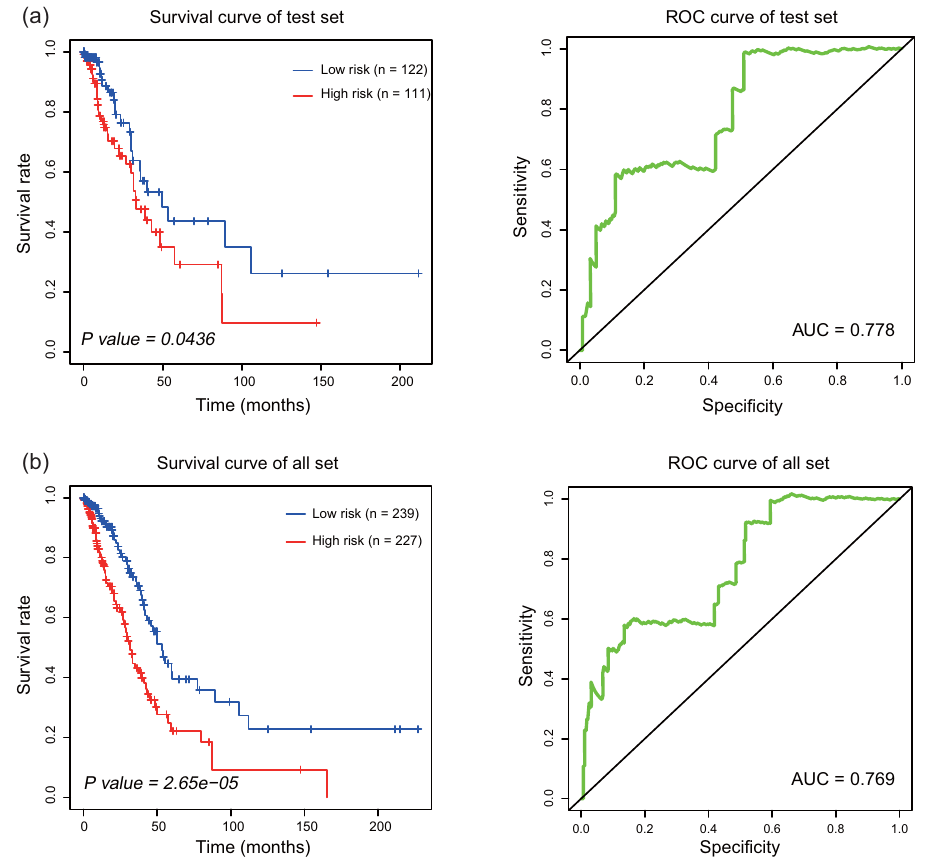
Figure 3: Prognostic value of four - lncRNA signature in the test set and entire set. ( a ) Kaplan – Meier curve and ROC curve analysis in the test set ( n = 233 ) . ( b ) Kaplan – Meier curve and ROC curve analysis in the entire set ( n = 466 )